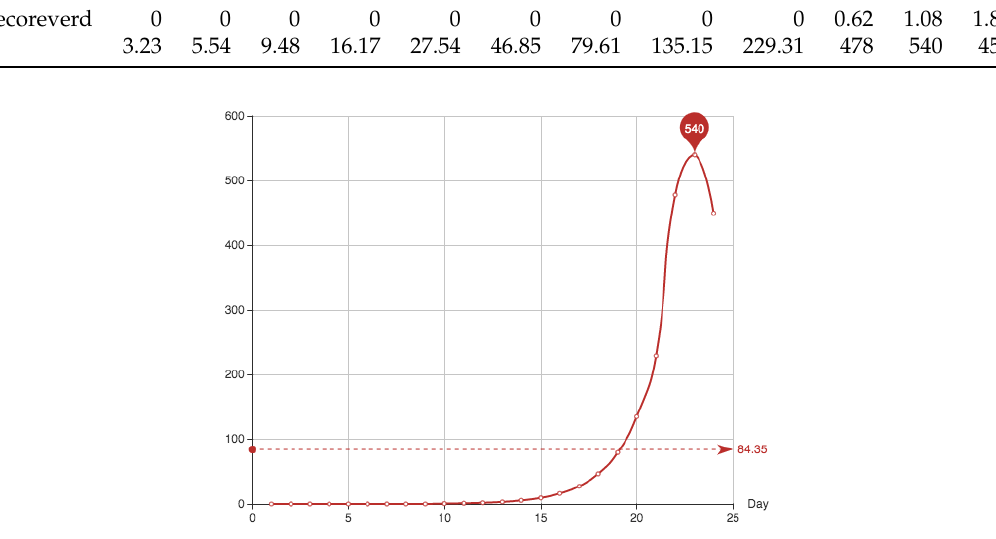
Figure 2. Simulation of the daily hospital discharges given by the function F . The dashed line is the average and the mark point is the maximum.